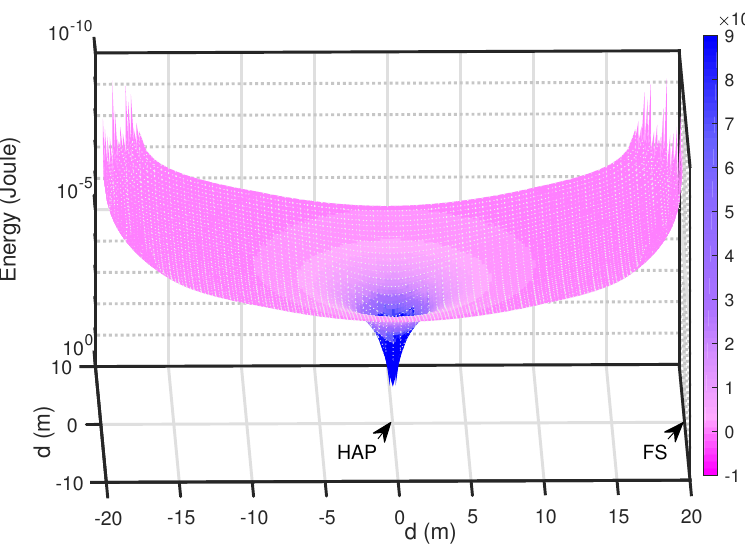
Figure 7. Energy requirements of selection